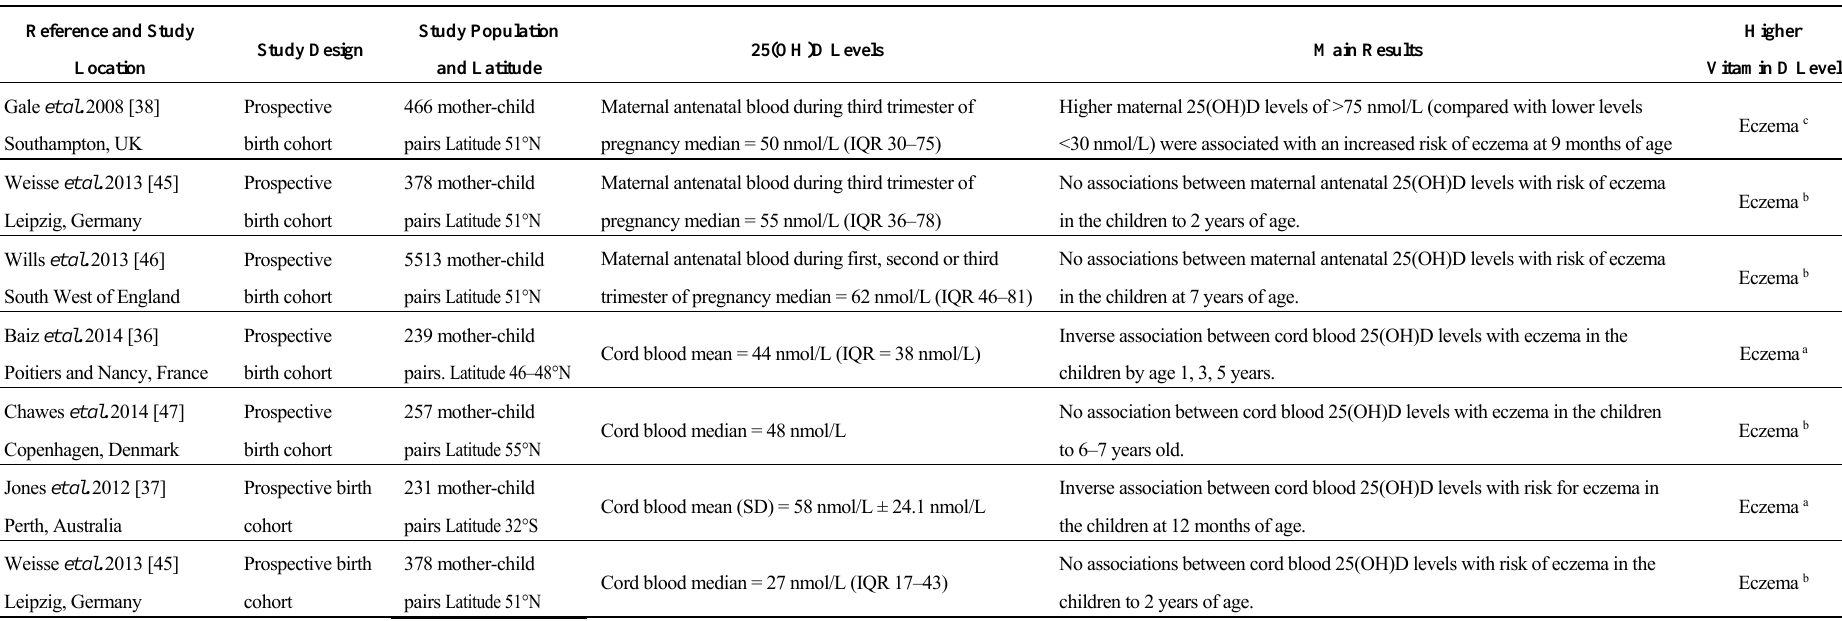
Table 1. Observational studies investigating maternal antenatal and/or cord blood 25(OH)D levels and eczema